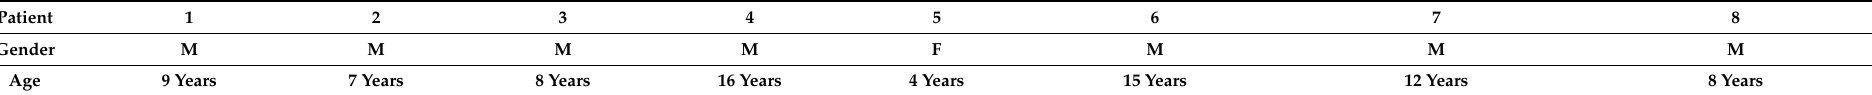
Table 1. Neuropsychiatric features of the